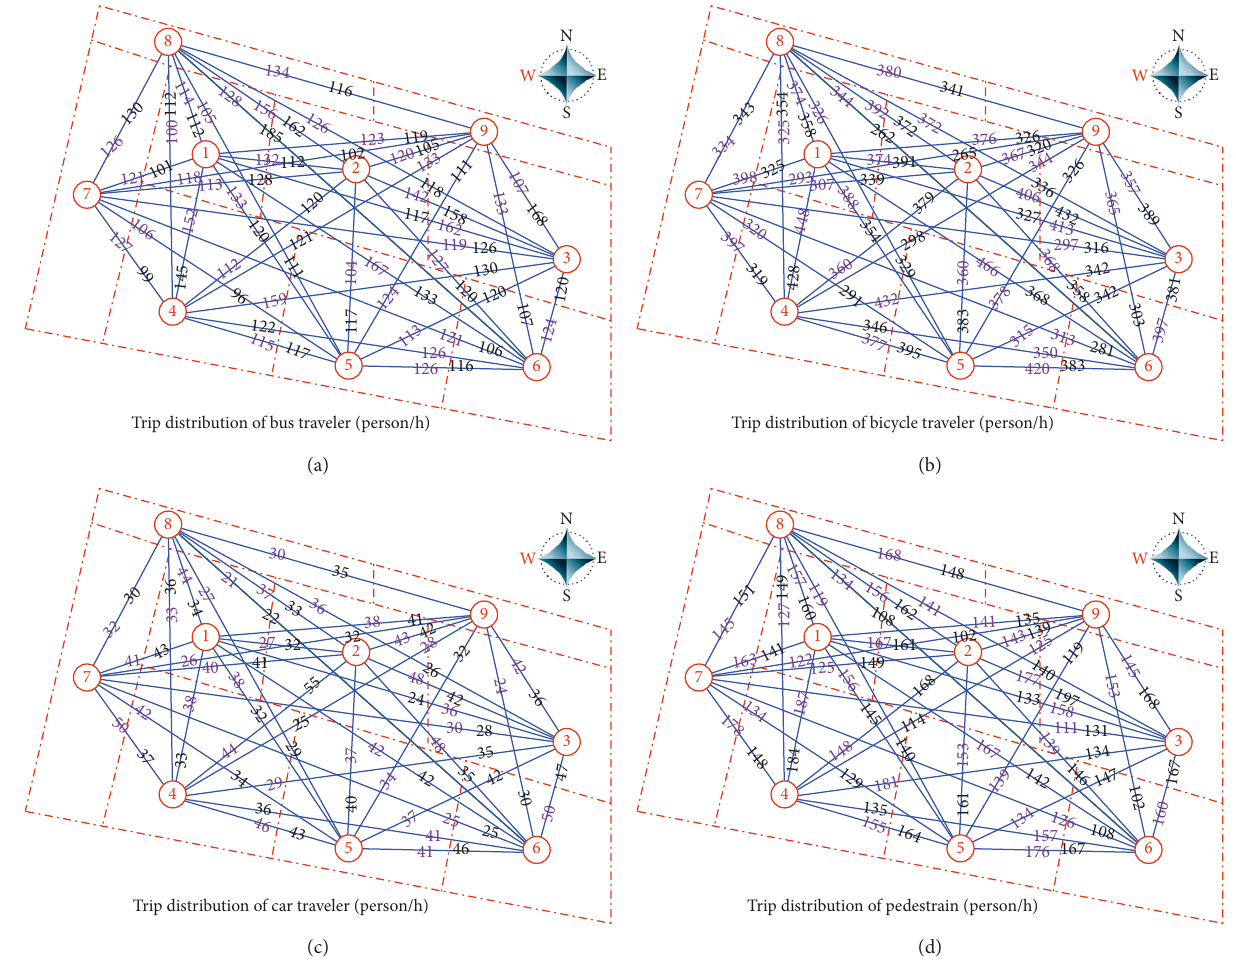
Figure 4: Trip distribution of each travel